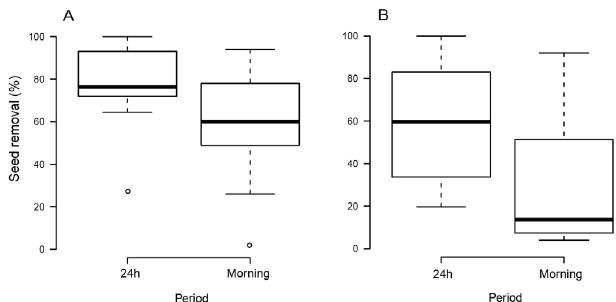
Fig 1 . Proportion of artificial seed s removed by ants during the morning period and after 24 h of seed exposure in non-impacted (A) and impacted (B) sites.